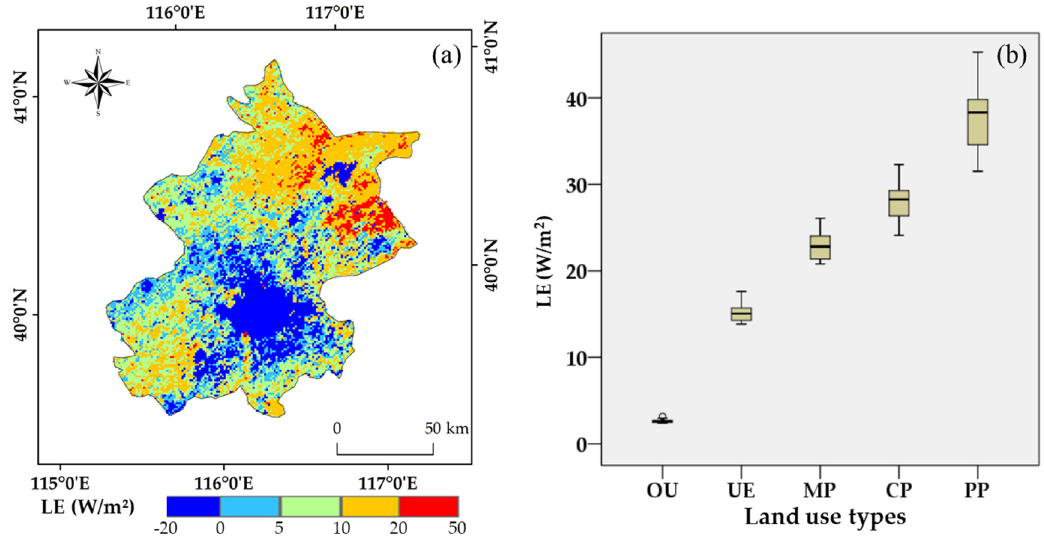
Figure 6. Latent heat flux (LE) in Beijing. ( a ) Spatial difference of LE from 2000 to 2015; ( b ) statistical feature values of the five land use types for LE from 2000 to 2015.